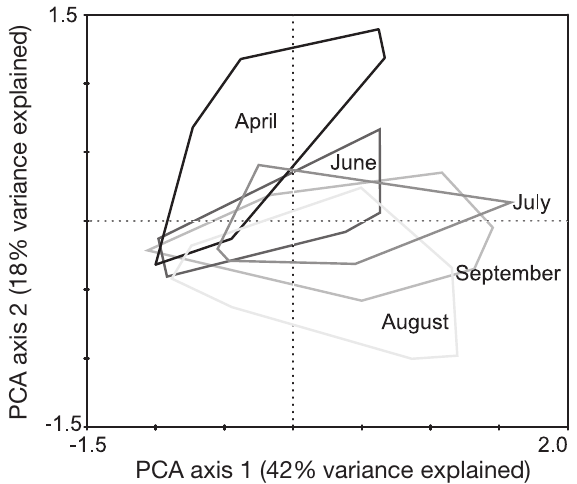
PCA axis 1 (42% variance explained) F IG . 4. – Plot of the principal component analysis of the temporal variability in beach litter abundance. The lines group the samples corresponding to the same